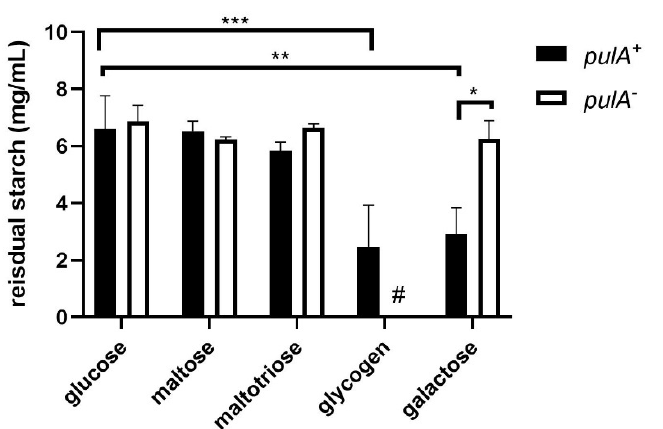
Figure 3. Cell-bound starch degrading activity of L. crispatus pulA sufficient and deficient strains grown on NYC-, glucose, maltose, maltotriose, glycogen (only pulA + ) and galactose. Cells were cultured in NYCIII medium supplemented with these carbohydrates and after centrifugation and resuspension of the pellet incubated in a starch solution (7.5 g/L). Asterisks indicate p -values calculated by Mann–Whitney of * p < 0.05, ** p < 0.005, *** p < 0.0005. Hashtag (#) indicates no data due to the absence of growth of this strain on glycogen.